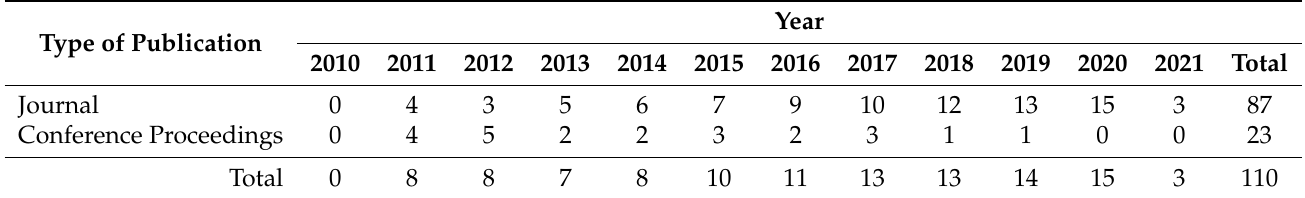
Figure 2. Numbers of Papers based on the Year of Publication. Table 2. Distribution of papers according to type of publication over the years.